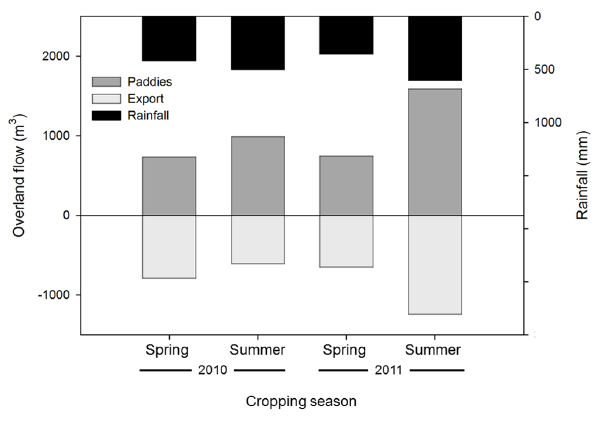
Figure 5. Total amount of water from overland flow during rainfall events, irrigated to the paddy fields and exported (negative on the y axis) out of the subwatershed via the irrigation channel per rice crop per year, and amount of rainfall per rice crop (note the different units on the y axis compared to Fig. 2).